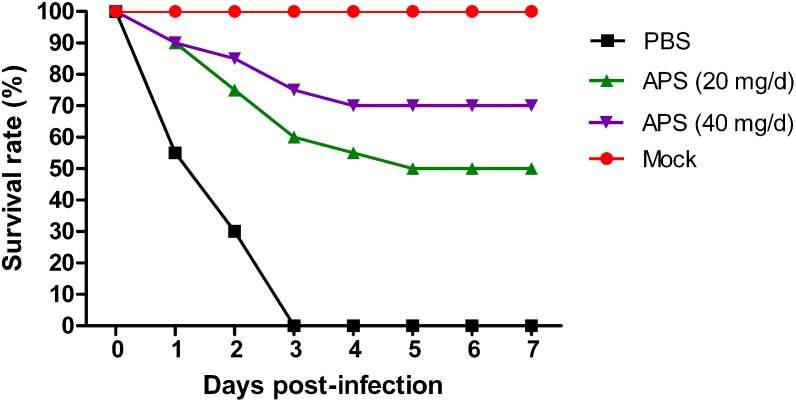
Aloe polysaccharides reduces mortality in virus-infected mice. Twenty mice in groups I, II, and III were infected intranasally with the 106 TCID50 of virus. Then the mice in groups I and II were orally administrated with 20 and 40 mg of APS per day, respectively, and group III were orally administrated isometric PBS. The virus-free mice in groups IV served as the normal control. The survival rate was monitored up to 7 dpi.